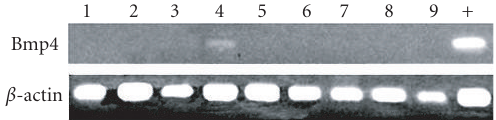
Figure 7: RT-PCR analysis of individual Bmp4 shRNA-exposed em- bryos from one entire litter. The positive control (+) is from an em- bryo exposed to pRed control vector alone. Pregnant dams were in- jected on E6.5 and RNA extracted from embryos on